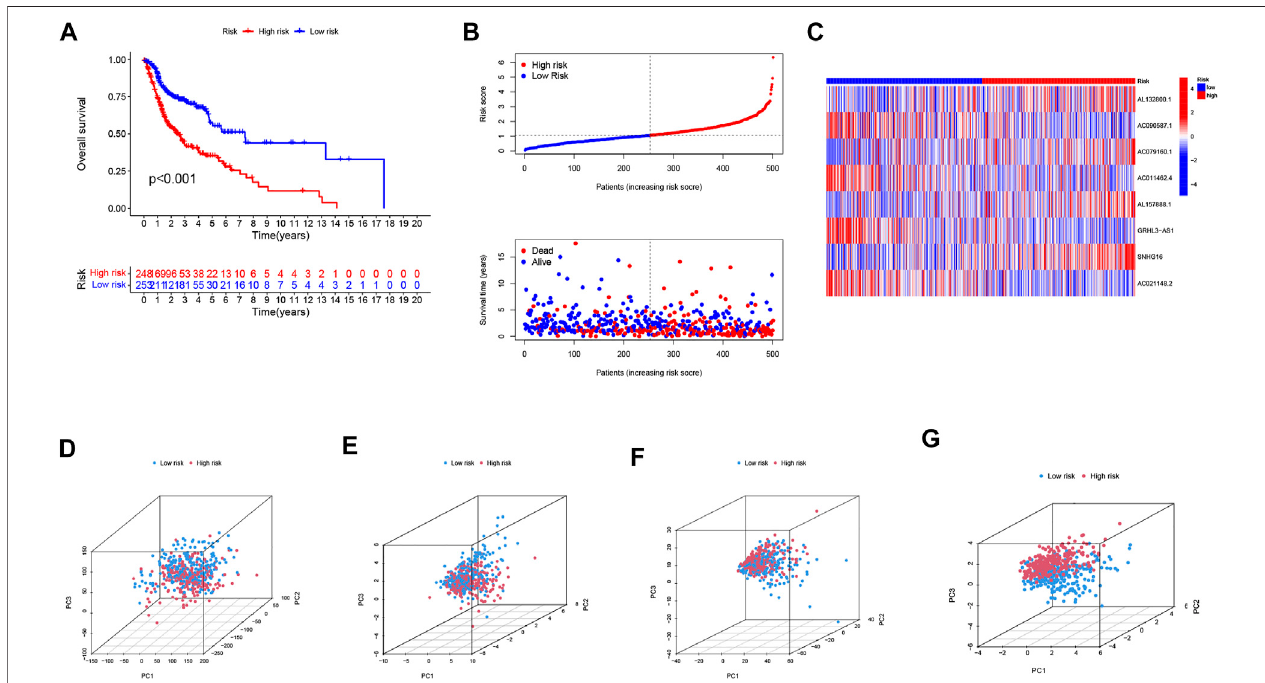
FIGURE 3 | Validation of the risk model in the entire cohort and principal component analysis. (A) Kaplan – Meier curves for survival analysis in the entire cohort. (B) risk scoredistributionand survivalstatusinthe entire cohort. (C) heatmap oftheprognostic markers and overall survivalin theentire cohort. PCA between thehigh- and low-riskgroupsbasedonthe (D) allgenes, (E) cuproptosis-relatedgenes, (F) cuproptosis-relatedlongnoncodingRNA(lncRNAs),and (G) cuproptosis-relatedlncRNAs prognostic